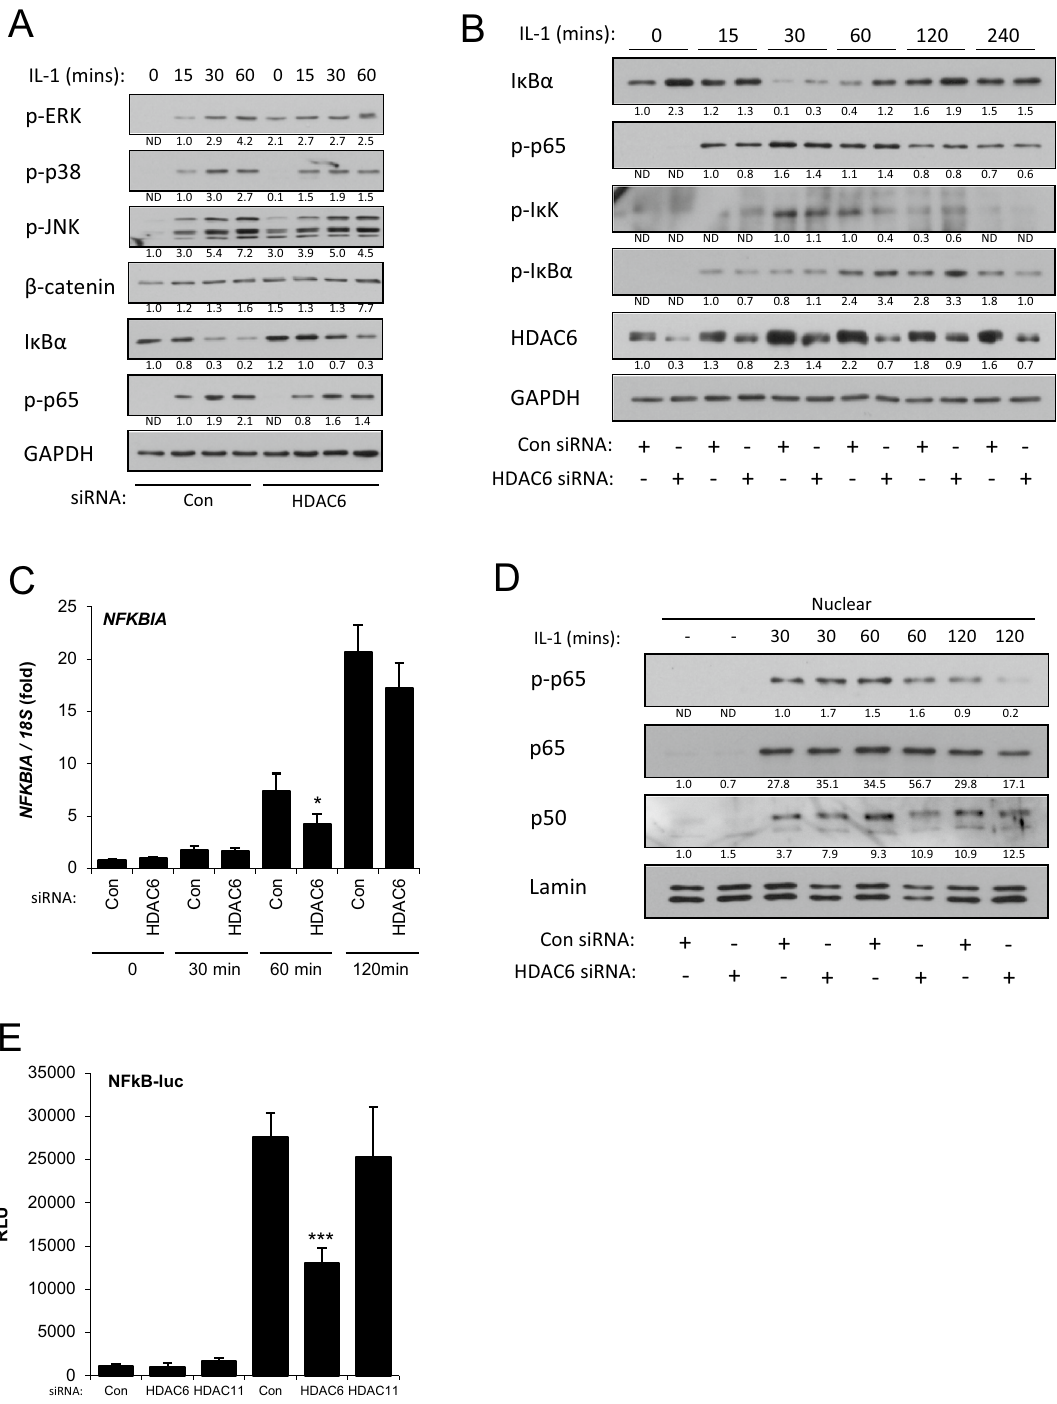
Figure 3. Effect of HDAC6 depletion on NF-κB pathway signalling in SW1353 cells. ( A – D ): SW1353 cells were stimulated with IL-1 for the indicated times following transfection with HDAC6-targetting siRNA or control non-targetting siRNA. ( A – B ). Total protein was extracted and the activation or abundance of the indicated ( A ) cell signalling pathway or ( B ) NF-κB pathway proteins detected by immunoblotting. HDAC6 levels were measured to confirm knockdown and GAPDH was used to confirm equal protein loading. Densitometric quantification data are shown below each blot as fold change in relation to the first detectable sample, normalised to GAPDH. ( C ) RNA was extracted and expression of NFKBIA (IkBα) measured by real-time RT-PCR. ( D ) Nuclear protein was extracted and the level of the indicated NF-κB pathway proteins detected by immunoblotting. Nuclear Lamin was used to confirm equal protein loading. Densitometric quantification data are shown below each blot as fold change in relation to the first detectable sample, normalised to Lamin ( E ). Luciferase expression in SW1353 cells stimulated with IL-1 for 24 h following transfection with HDAC6 or HDAC11-targetting siRNA or control non-targetting siRNA and an NF-κB luciferase reporter. Values are the mean ± SD, * = P < 0.05, *** = P < 0.001 versus non-targetting control. Data are representative of a minimum of three independent